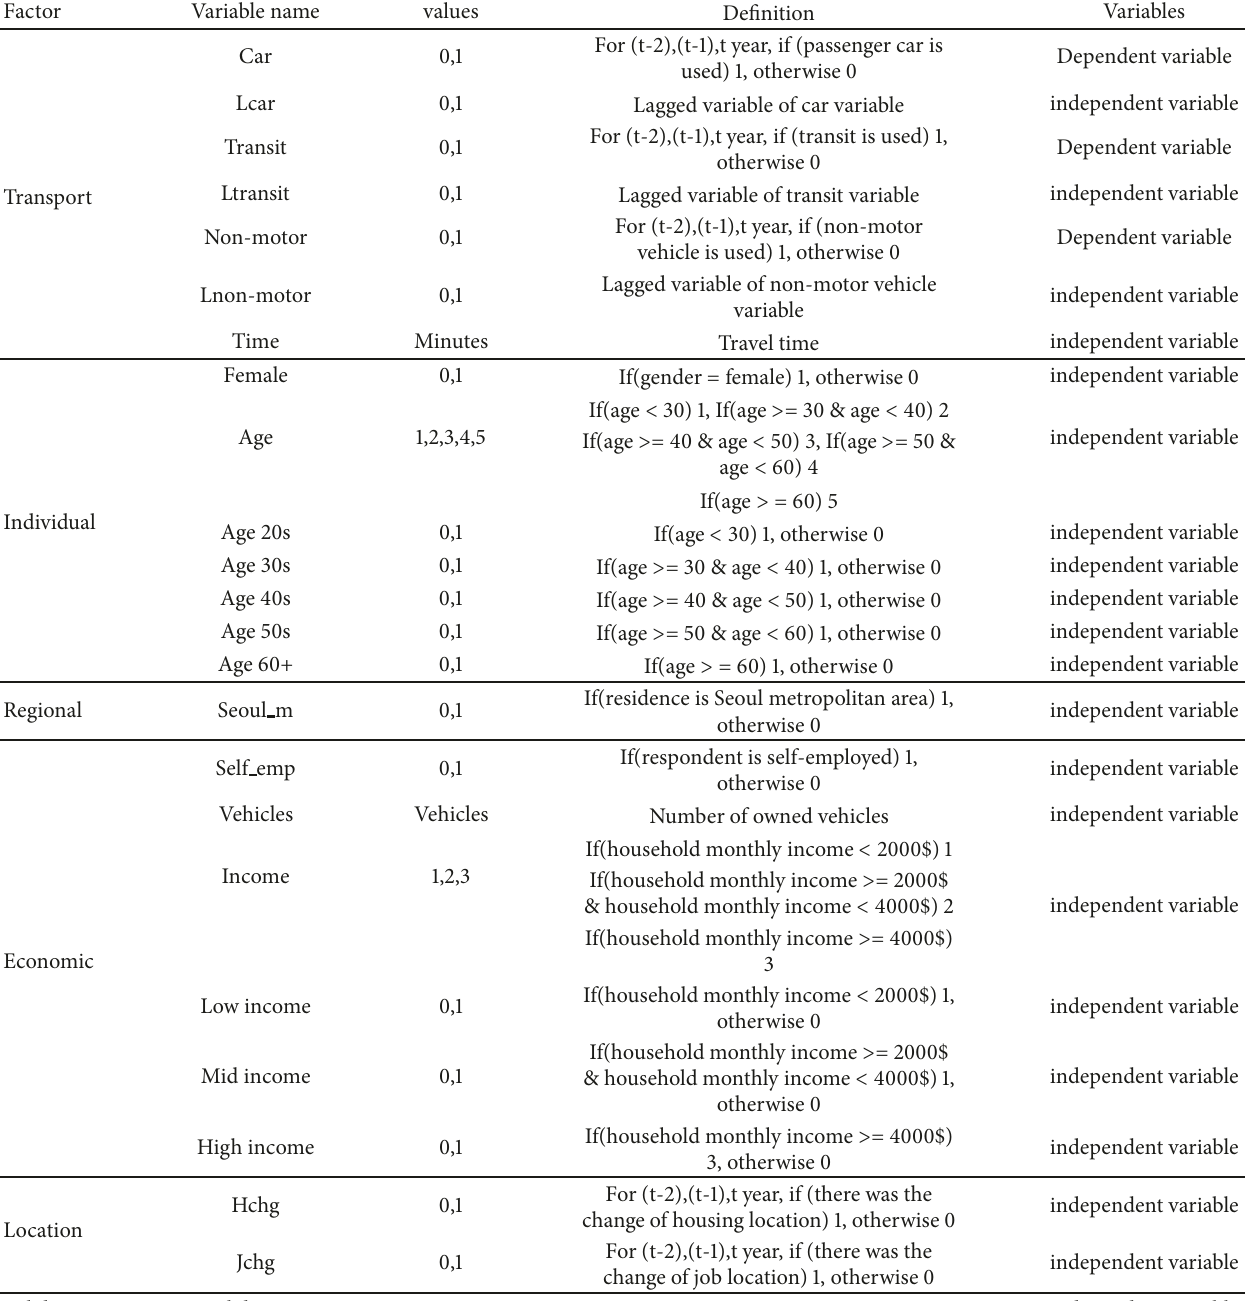
Table 1: Definition of used